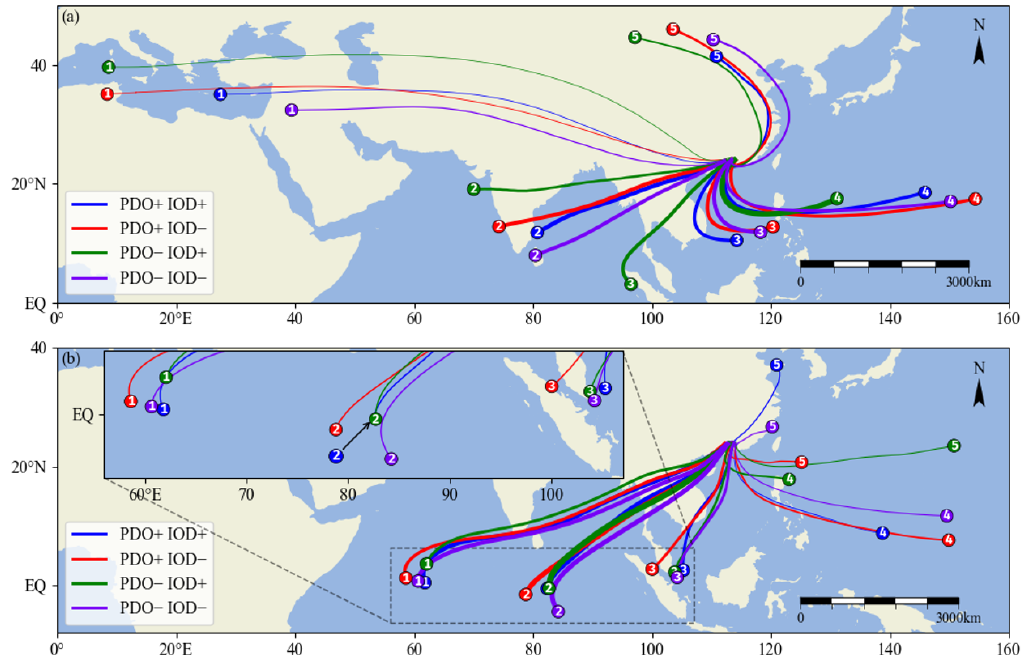
Figure 3. Clustering path of water vapor transport trajectories of precipitation for positive/negative phase of IOD in the preflood season over SC with the synergy of PDO (1960–2012) (( a ) the frontal precipitation, ( b ) the monsoon precipitation, blue line: clustering trajectories for PDO positive phase and IOD positive phase, red line: clustering trajectories for PDO positive phase and IOD negative phase, green line: clustering trajectories for PDO negative phase and IOD positive phase, purple line: clustering trajectories for PDO negative phase and IOD positive phase, the number at the start of the trace is the trace number). Table 2. Percentage of track number for clustering path in the total number of water vapor transport tracks and effective precipitation track number for clustering path in its total track number in the preflood season over SC for phase combinations of IOD and PDO (1960–2012) (unit: %).